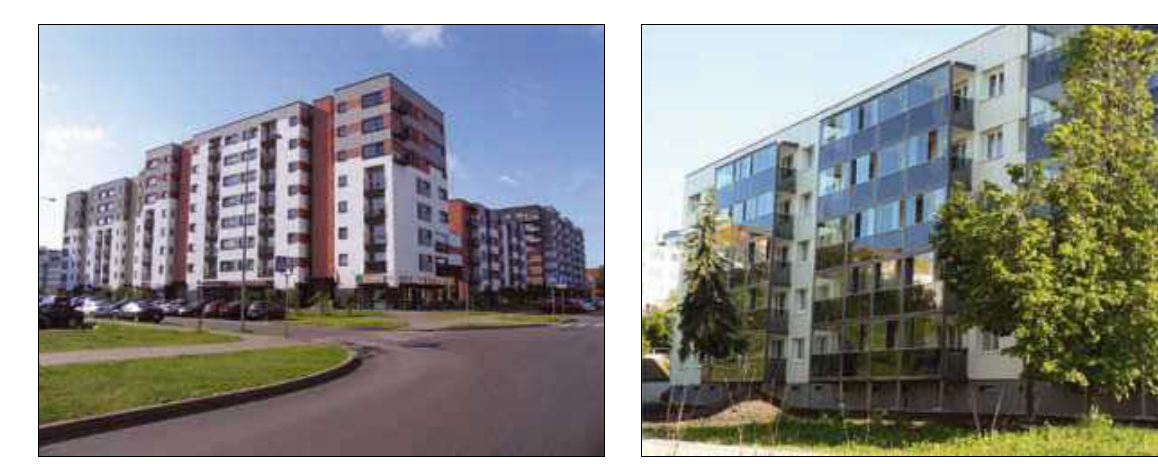
Fig. 25. complex of blocks of flats in k. Ladyga/ J. ku­biliu­s